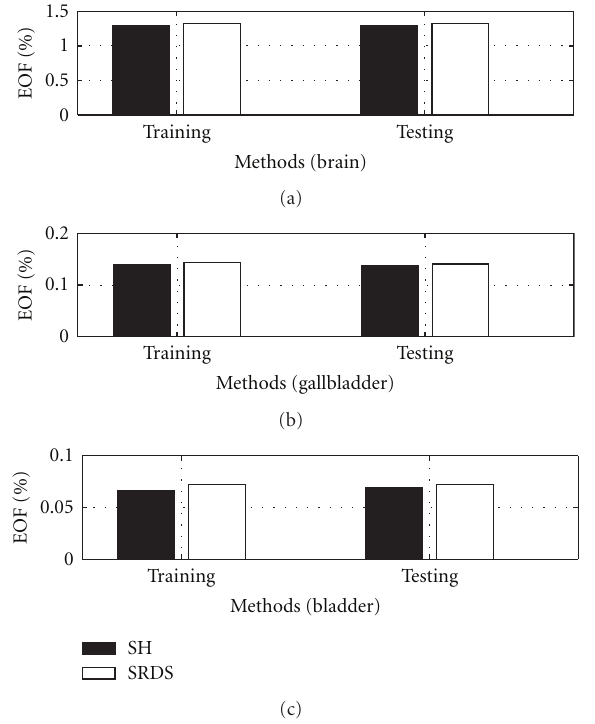
Figure 9: Sparsity ( μ ) of surface representation changes with dif- ferent ε on three axis: (a) is for training set; (b) is for testing set.